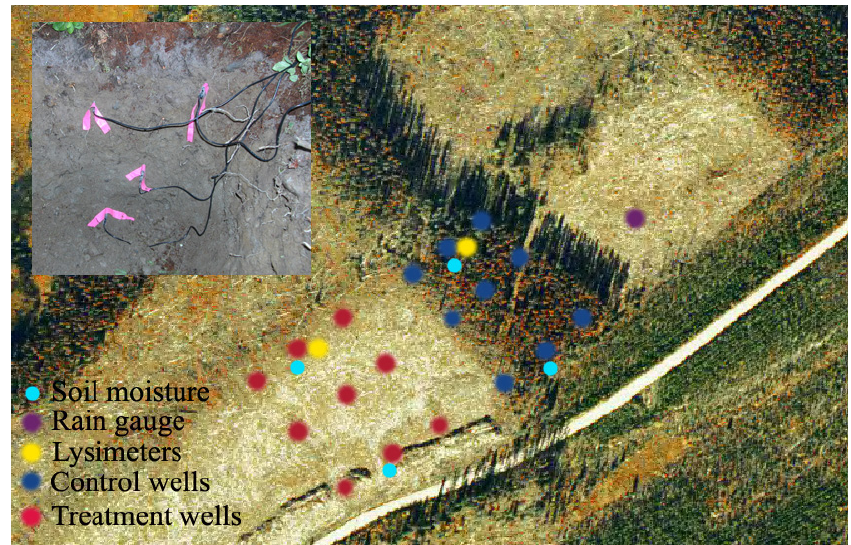
Figure 2. Orthophoto image of the Belisle Creek detailed assessment site showing site design (Inset shows Thetaprobes at 10, 20, 40, and 60 cm